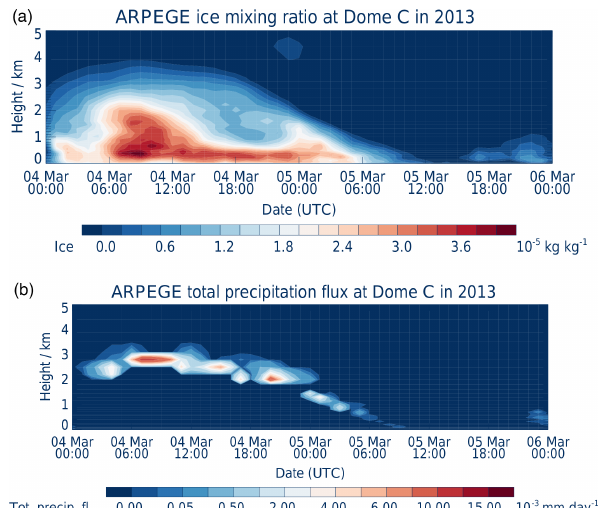
Figure 9. Time evolution of the ice water mixing ratio ( a ) and of the total precipitation flux ( b ) from 4 to 5 March 2013 above the Dome C station as calculated by the ARPEGE model.